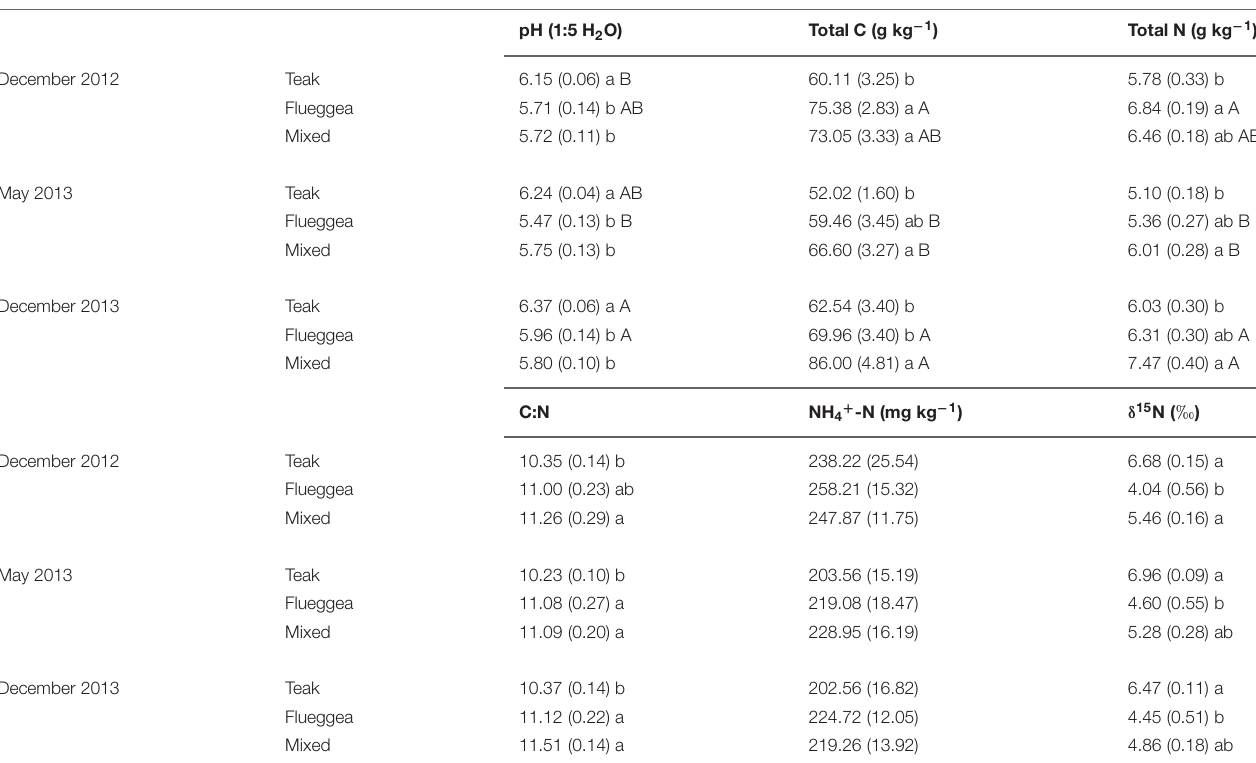
TABLE 2 | Soil chemical characteristics measured in different plantation types and at different sampling times at Kolombangara, Solomon